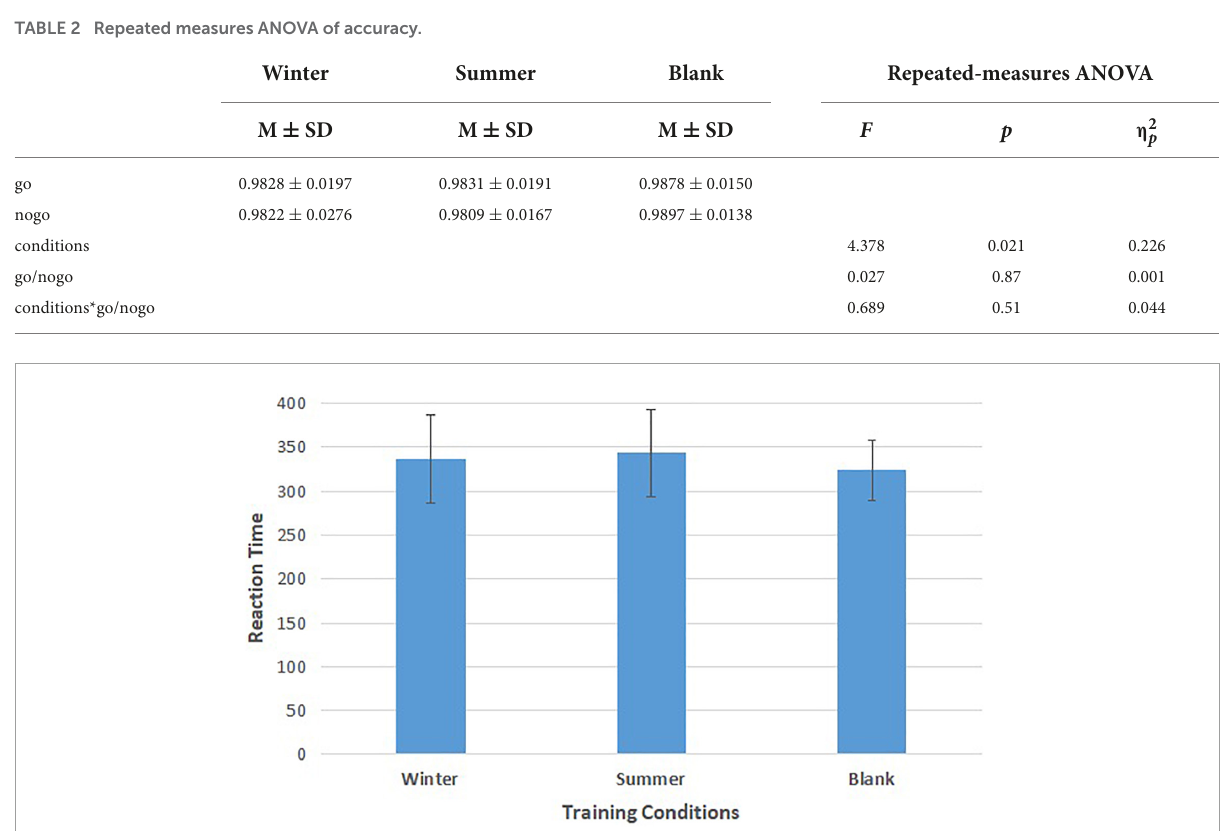
TABLE 2 Repeated measures ANOVA of accuracy.